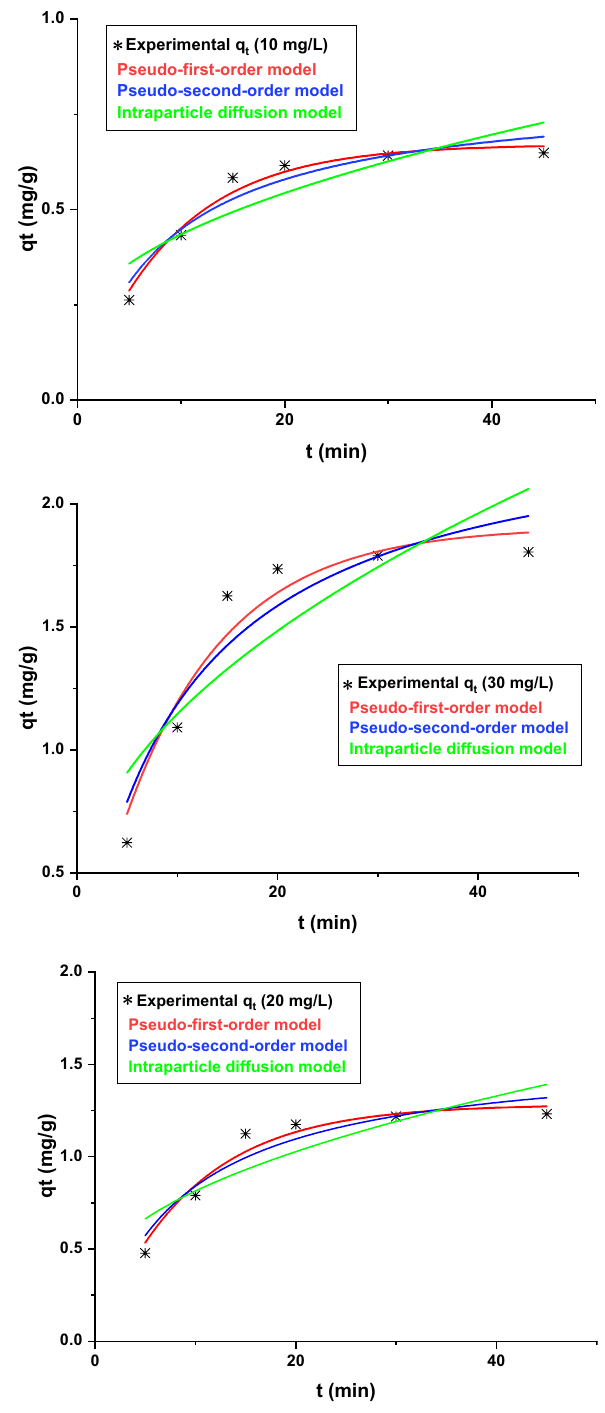
Figure 8. Fitting the three widely kinetic models for Pb(II) adsorption by